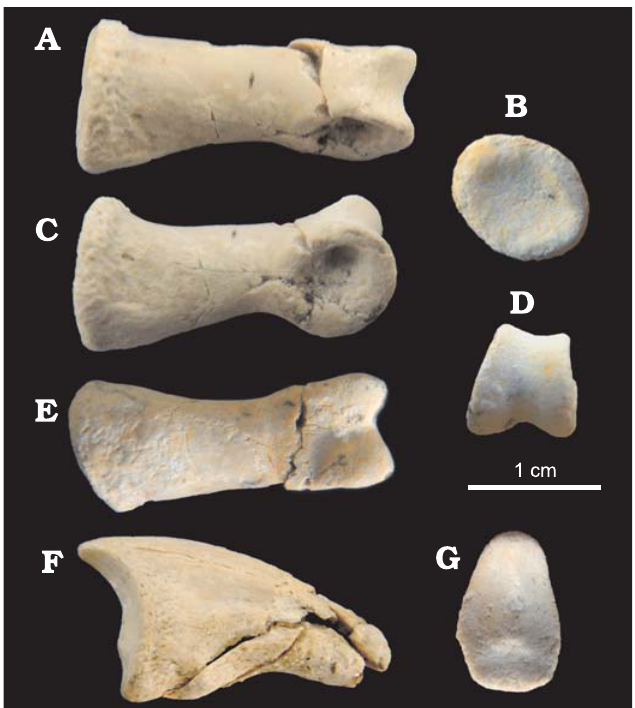
Fig. 11. Crested theropod dinosaur Elmisaurus rarus Osmólska, 1981, MPC-D 102/007 from Nemegt Formation (Upper Cretaceous), Western Sayr of Nemegt locality, Mongolia. Pedal phalanges I-1 ( A – E ) and I-2 ( F , G ) in dorsal (A), proximal (B, G), lateral (C, F), distal (D), and ventral (E)